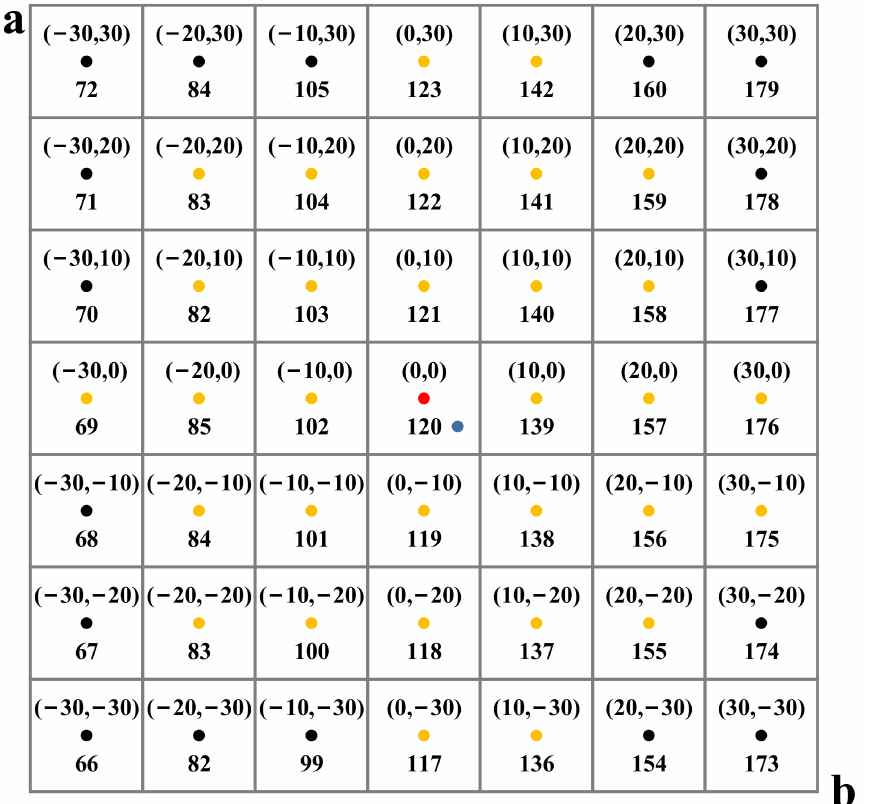
Figure 3. Part of the color category distribution. The lower half values of the small squares are their corresponding color categories q. For the pixel (blue dot) ( 3, − 3 ) , the same color category 120 is obtained for the method of Zhang et al. and our